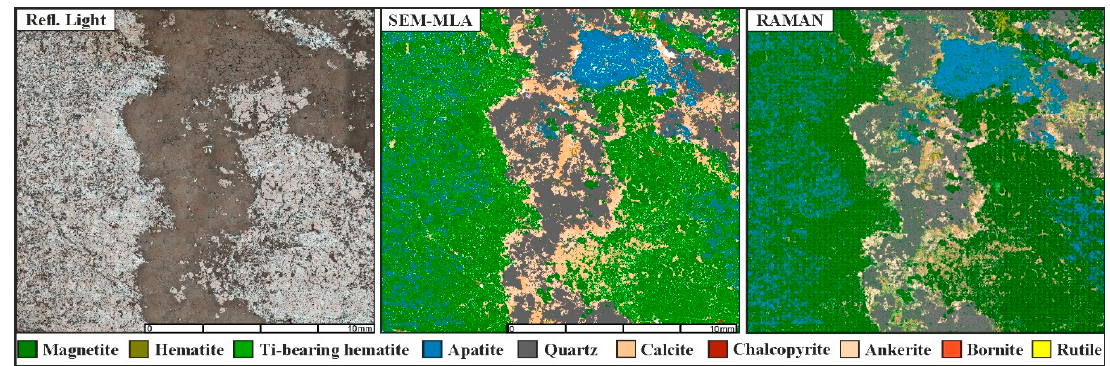
Figure 2. Mineral distribution maps from reflected light (optical microscopy) and processed SEM-MLA and Raman analysis.